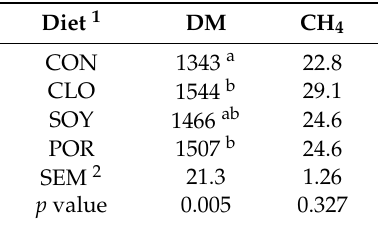
Table 6. Average daily DM intake (g / day) and enteric methane production (L CH 4 / kg DM) in sheep fed the experimental diets in in vivo Experiment